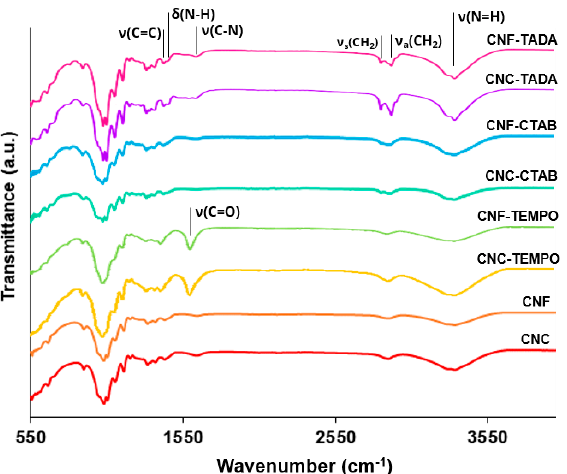
Figure 1. ATR-FT-IR spectra of the modified and unmodified cellulose nanocrystals (CNC) and cellulose nanofiber (CNF) materials. Nanocellulose modifications were performed with cetyltrimethylammonium bromide (CTAB), tannic acid and decylamine (TADA), and by TEMPO-mediated oxidation (TEMPO).